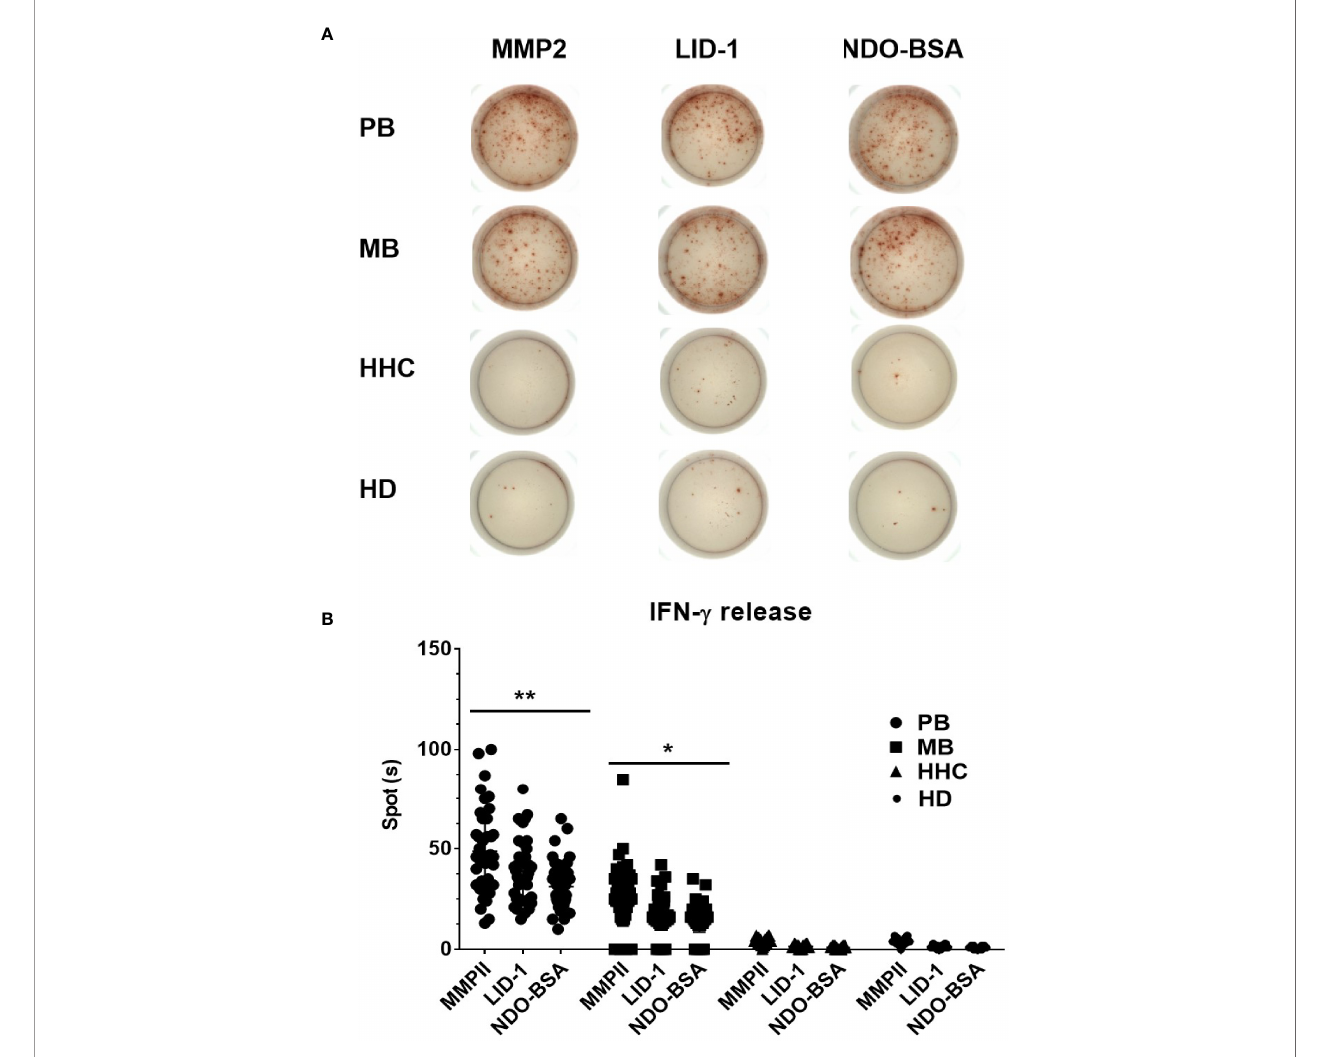
FIGURE 3 | Comparative analysis of IFN- g expression of ELISPOT in blood samples. Clinically diagnosed PB leprosy (n = 98), clinically diagnosed MB leprosy (n = 202), HHC (n = 150), and HD (n = 150) were detected with IFN- g expression using ELISPOT (A) and analyzed by GraphPad Prism (B) . *p<0.05, **p<0.01.